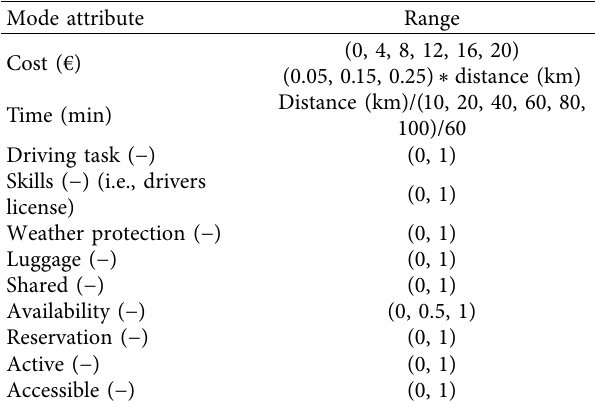
Table 4: Ranges of mode attributes of new mobility